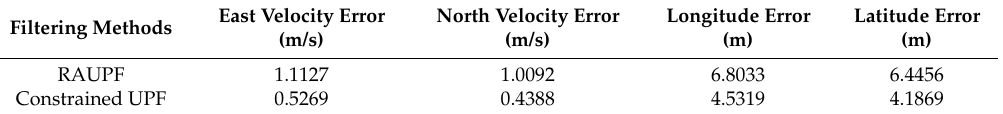
Table 3. Mean errors of velocity and position under the wind speed of 20 m/s.